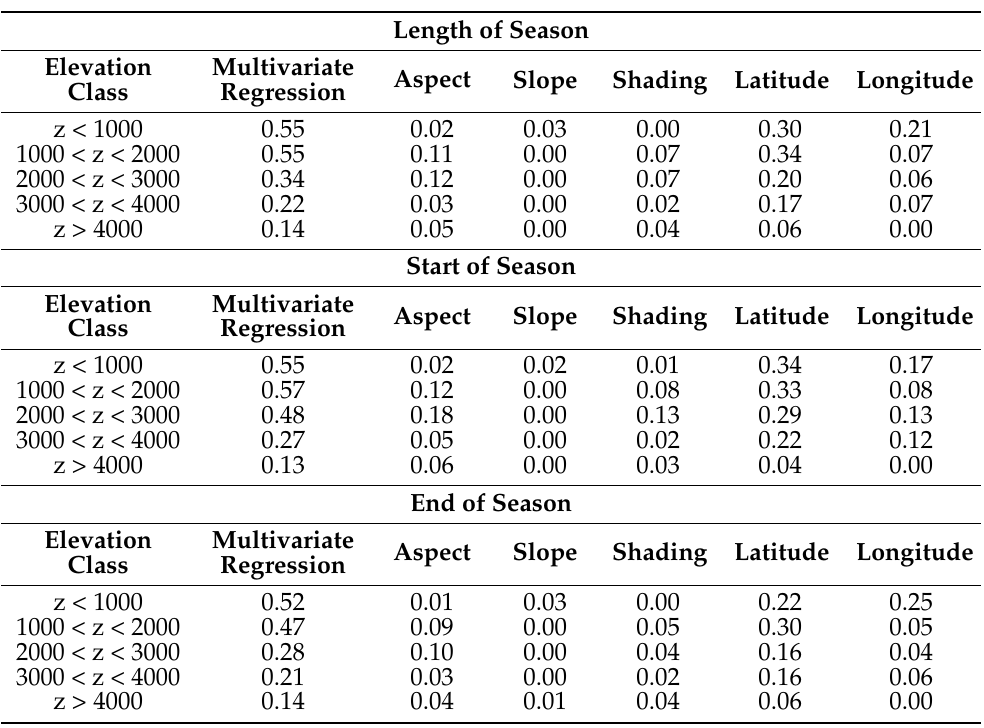
Table 3. Variance explained by the linear regression of individual variables against the three metrics in the GAR for different elevation classes. Elevation is removed by subtracting the average in each 5-m elevation interval, and a linear regression is applied to the residuals. z represents elevation (m a.s.l.). Each cell reports the R 2